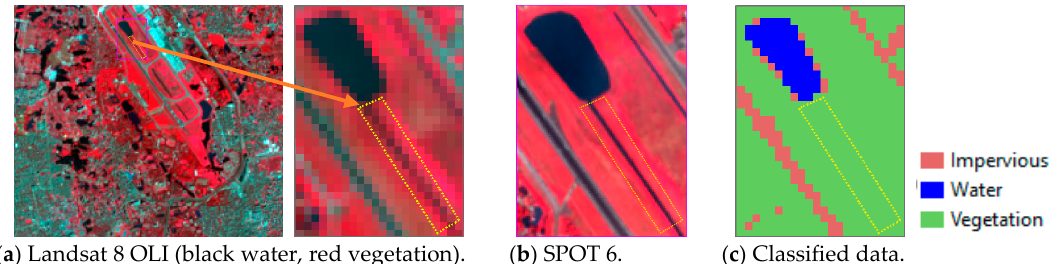
Figure 18. Effect of image resolution to the detection of small bodies of water.